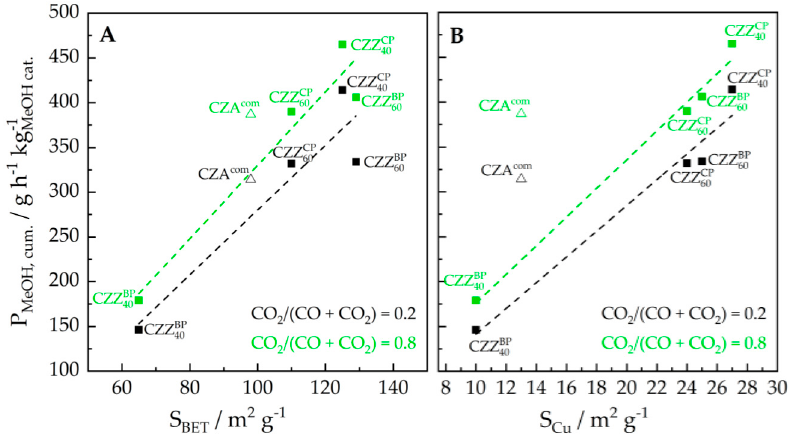
Figure 6. Cumulative MeOH productivity P MeOH, cum. of CZZ / FER and CZA / FER catalysts as a function of ( A ) the specific BET surface area S BET and ( B ) the specific copper surface area S Cu . CZA com was not considered in linear fitting. Conditions productivity tests: CO 2 / (CO + CO 2 ) = 0.2 (black)